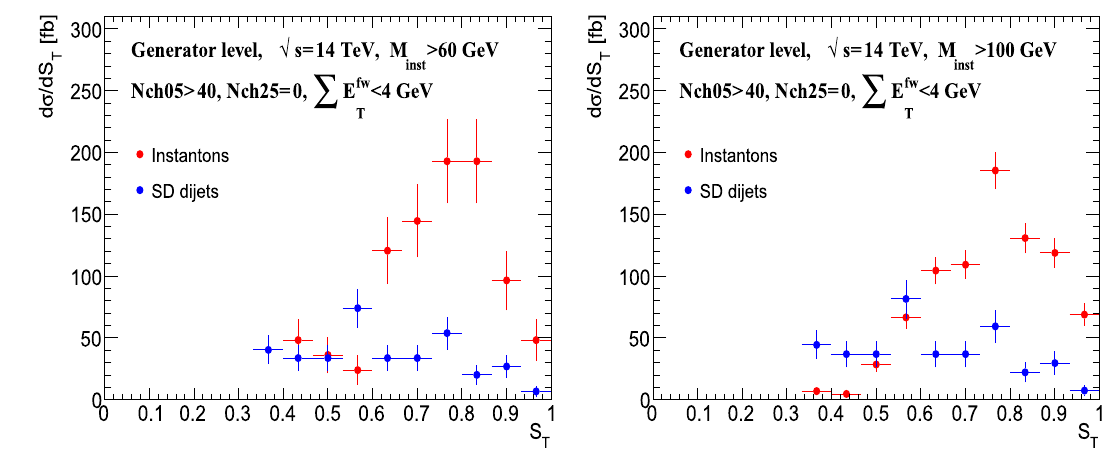
on the right) generated by RAMBO and SD dijet background generated by PYTHIA 8.2 for the golden cut scenario (Eq. (8)). Only statistical uncertainties are